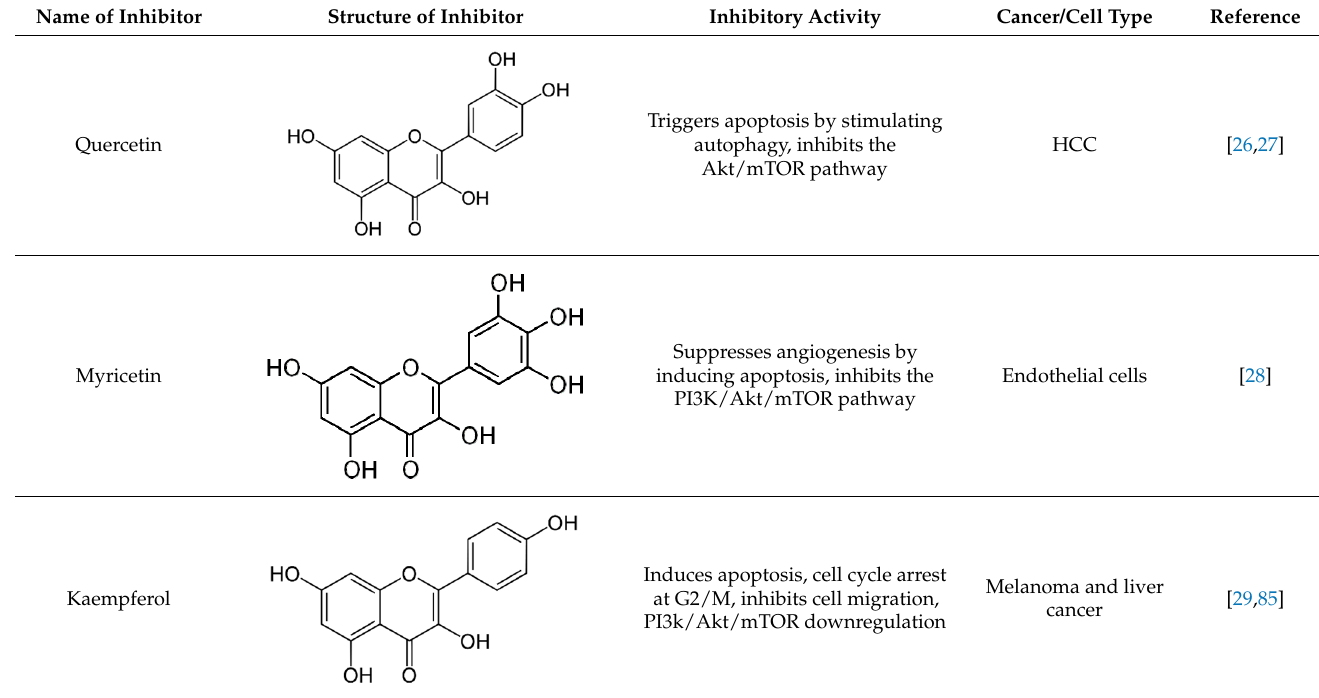
Table 2. Different flavonoids and their PI3K/Akt/mTOR inhibitory activity.